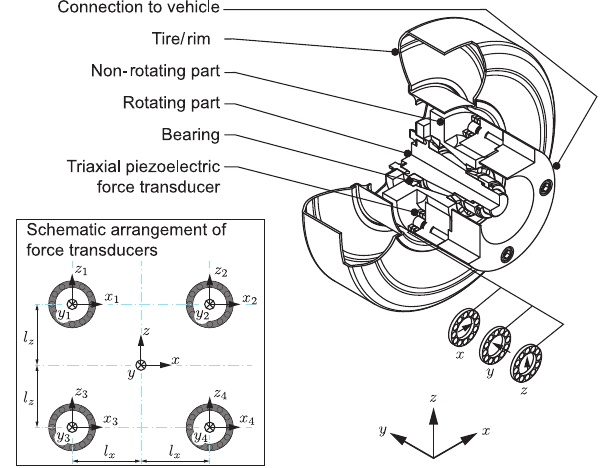
Figure 2. Non-rotating dynamometer for a car tire according to Ev- ers et al. (2002) and Bonfig (1995).